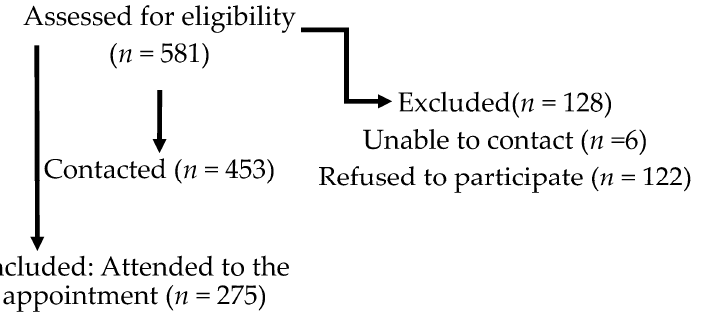
Figure 1. Flow diagram of the study participants.